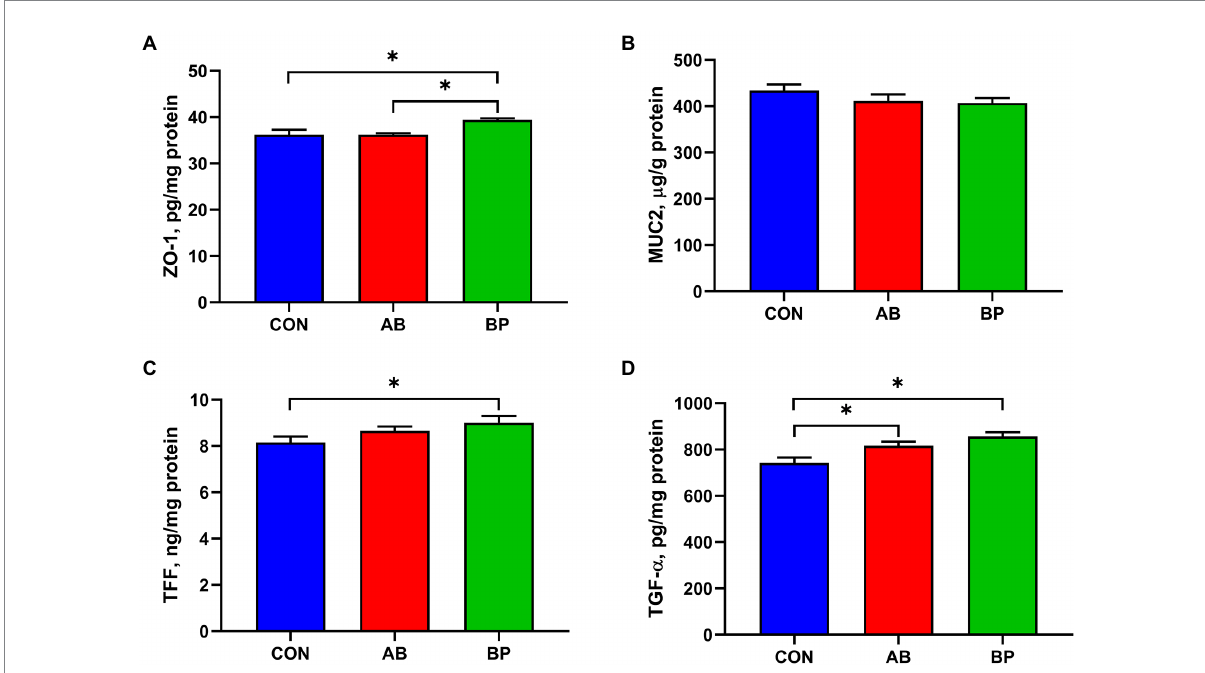
FIGURE 3 Effects of dietary supplemented with Bopu powder on intestinal barrier factors in broiler chickens. (A) Zonula occludens-1 (ZO-1); (B) Recombinant mucin 2 (MUC2); (C) Trefoil peptides (TFF); and (D) Transforming growth factor alpha (TGF- α ). CON group, broiler chickens fed a basal diet; AB group, broiler chickens fed a basal diet supplemented with 50 mg/kg aureomycin; and BP group, broiler chickens fed a basal diet supplemented with 40 mg/kg Bopu powder containing protopine and allocryptopine. Values are mean ± standard error ( n = 6). * p <